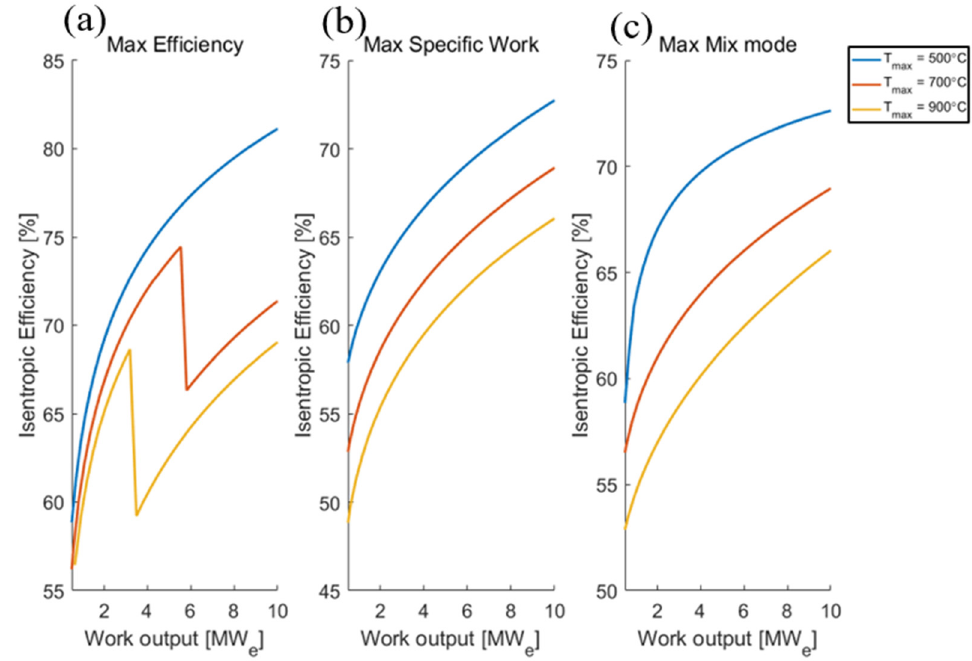
Figure 24. Compressor Isentropic Efficiency of S-CO 2 Brayton cycle for ( a ) max efficiency, ( b ) max specific work and ( c ) max mix mode.